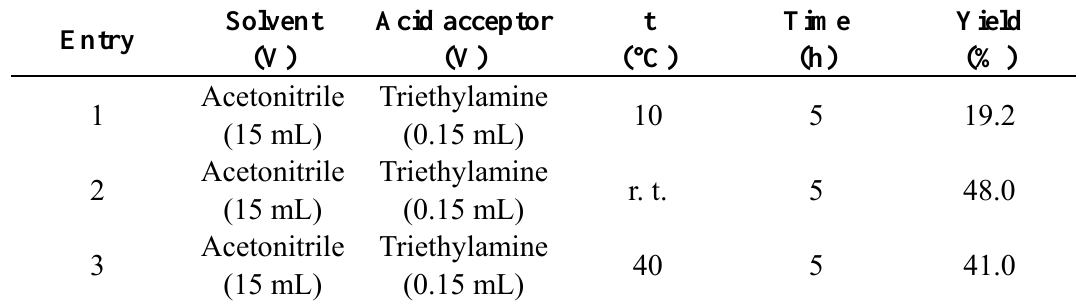
Table 2. The effect of temperature on the yield of compound 7b